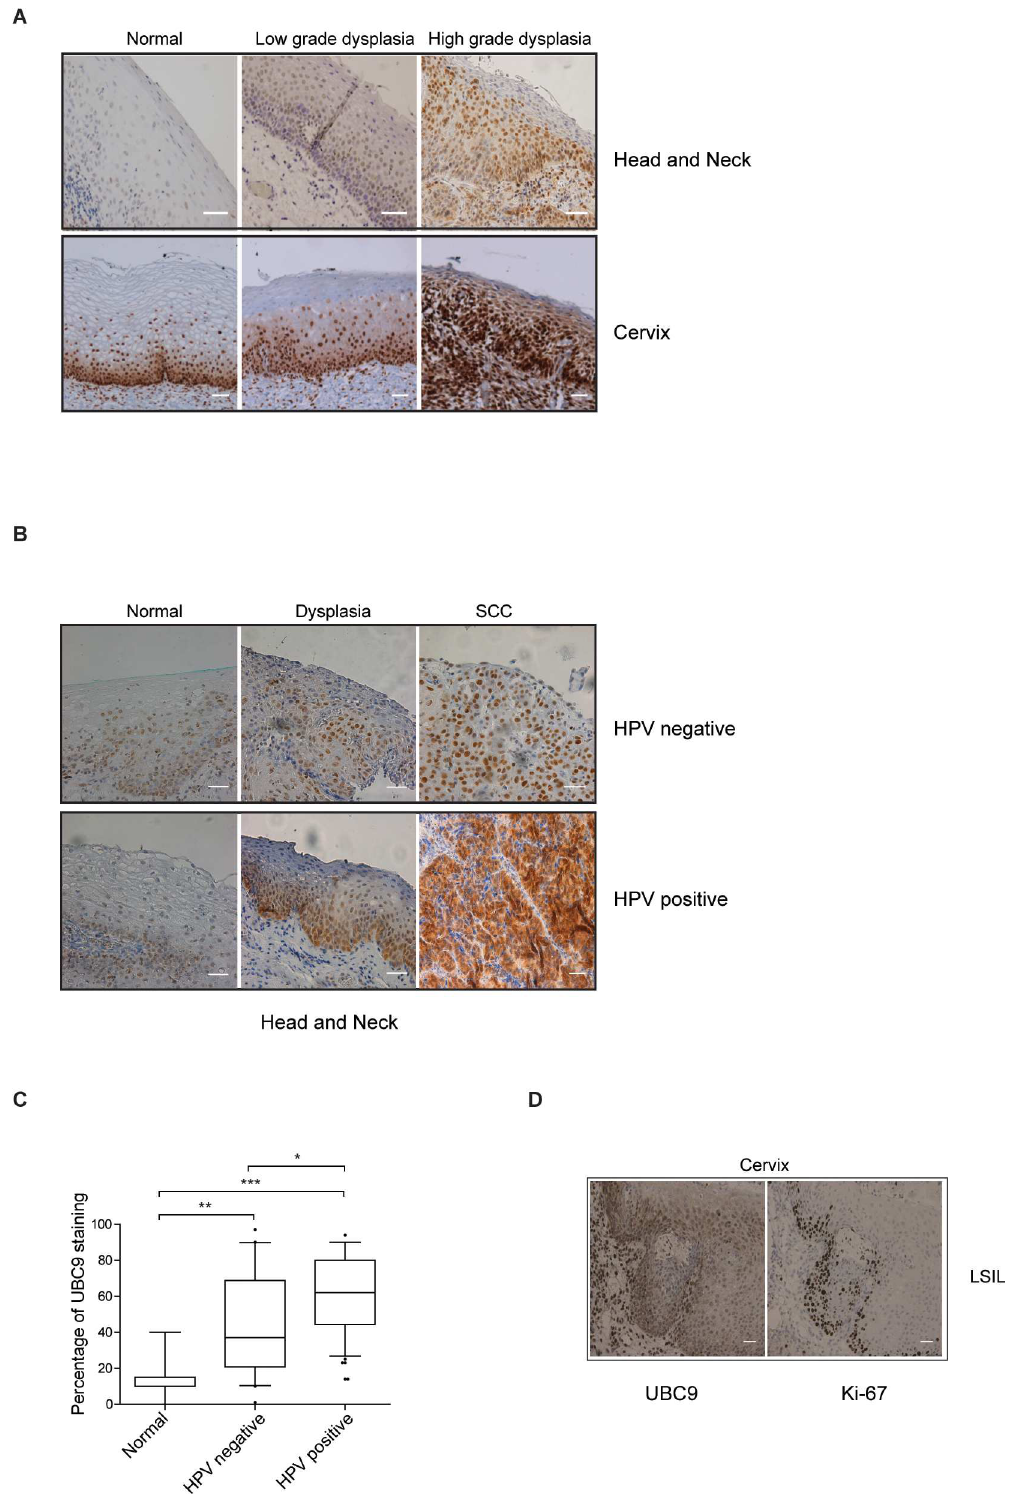
Fig 1. UBC9is up-regulated during both cervicaland head and necktumorigenesis. (A) Representative IHC imagesof FFPE humannormal,lowgradeor highgradedyplasiacervicalor HN oropharyngealtissues, asindicated, stainedwithanti-UBC9antibody.Scalebars= 200nm. (B) Representative IHCimagesFFPE humannormal,dysplastic or tumoral(squamouscellcarcinoma-SCC)HNoropharyngealHPV positiveor negativetissues,asindicated,stained withanti-UBC9antibody.Scalebars= 200nm.Sampleswereclassified asHPV positiveby DNAandRNAtesting,as